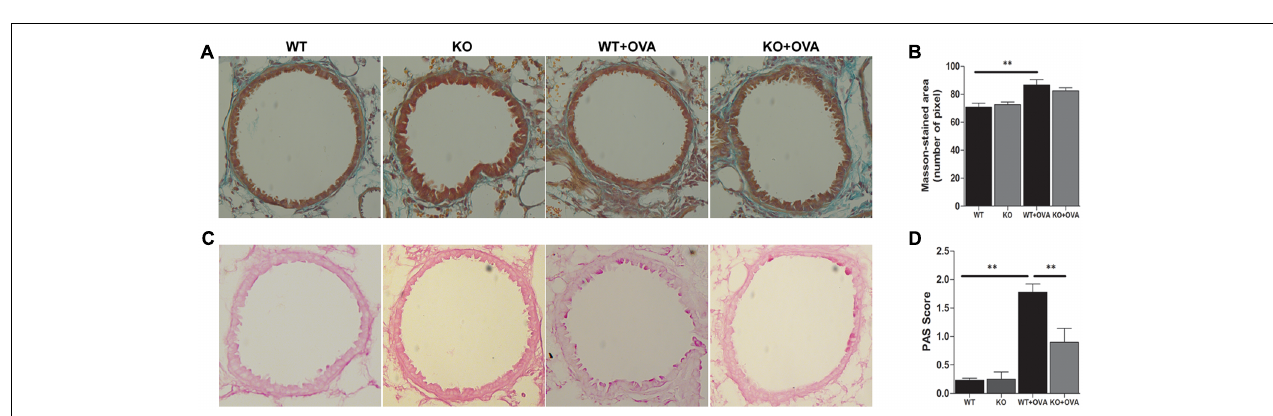
FIGURE 3 | Gene deletion of KCa3.1 prevented established airway remodeling. (A) Representative images were obtained of Masson trichrome-stained lung sections from WT, KO, WT + OVA, and KO + OVA groups (original magnification, X 30). (B) Random measurements from the basement membrane into the submucosa (10 measurements of 20 µ m in length) were taken, and the mean density was calculated from four bronchi per mouse ( n = 5). ∗∗ p < 0.01, one-way ANOVA followed by the Dunnett’s multiple comparison test compared with WT + OVA mice. (C) Representative images were obtained of PAS-stained lung sections from WT, KO, WT + OVA, and KO + OVA groups (original magnification, X 30). (D) PAS-stained sections were scored. Data were presented as means ± SEM ( n = 5). ∗∗ p < 0.01, one-way ANOVA followed by the Dunnett’s multiple comparison test compared with WT + OVA mice. WT, wildtype; KO,